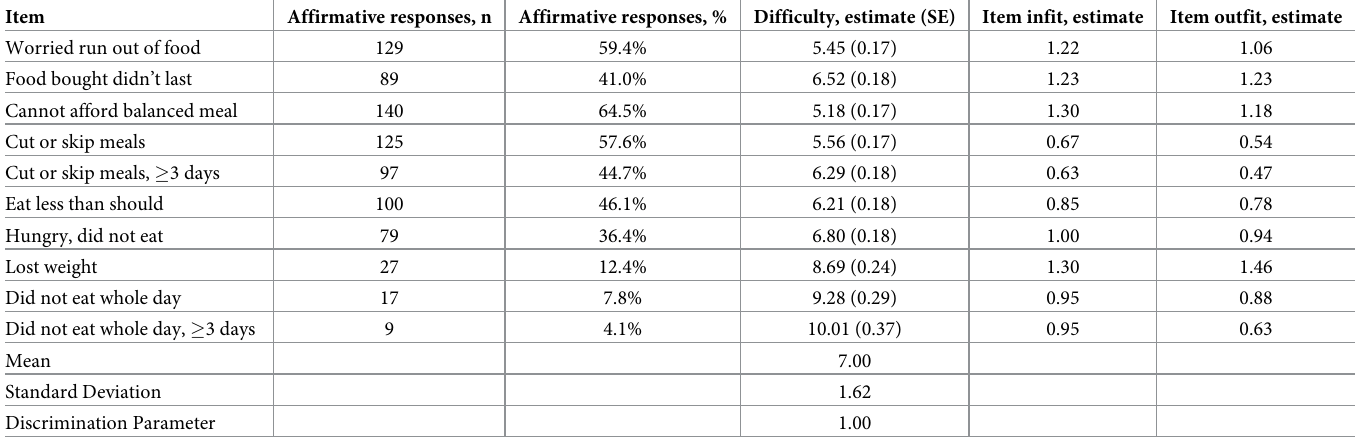
Table 3. Item response statistics for 10-item adult food security survey module among a random sample of undergraduate students who participated in an online survey (n = 217 a